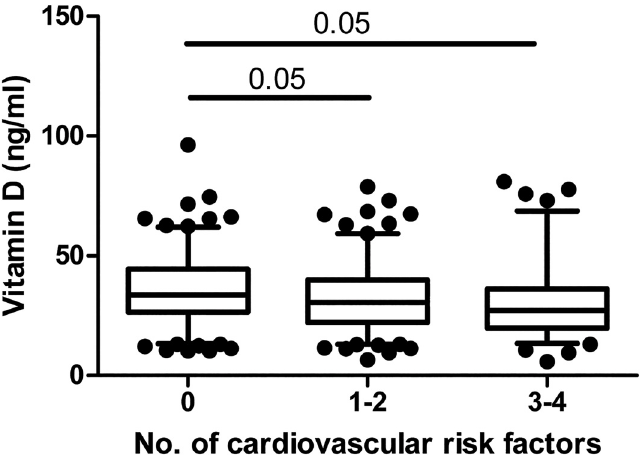
Fig 1. Plasma 25(OH)D 3 concentration according to absence or presence of cardiometabolic risk factors. Central obesity: waist-to-height ration > 0.5 [31]; elevated blood pressure (BP): systolic BP (cid:1) 130 mm Hg and/or diastolic BP (cid:1) 85 mm Hg; increased atherogenic risk: AIP (cid:1) 0.11 [29]; and insulin resistance: QUICKI < 0.322 were considered as factors indicated increased cardiometabolic risk. 0: no risk factor presented (n = 162); 1 – 2: subjects with 1 or 2 risk factors (n = 162); 3 – 4: subjects presenting 3 or 4 risk factors (n = 87). Data are given as interquartile range (box), 5 th and 95 th percentile (whiskers). Statistical evaluation was performed on natural ln-transformed data. ANOVA: p < 0.001, Scheffe ’ s post hoc test p indicated.